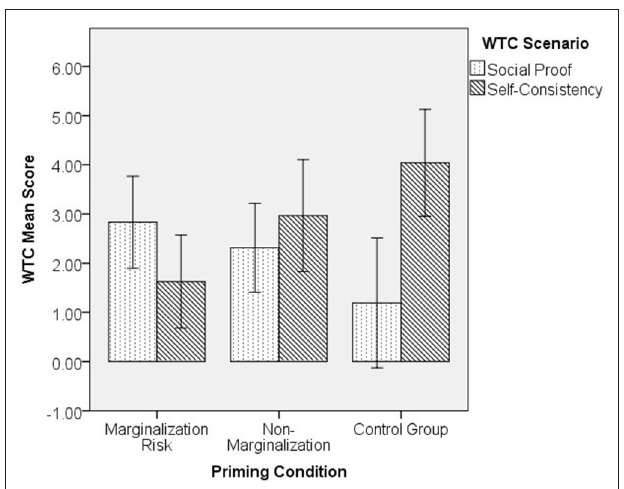
FIGURE 1 | Priming conditions and compliance motivation across samples.